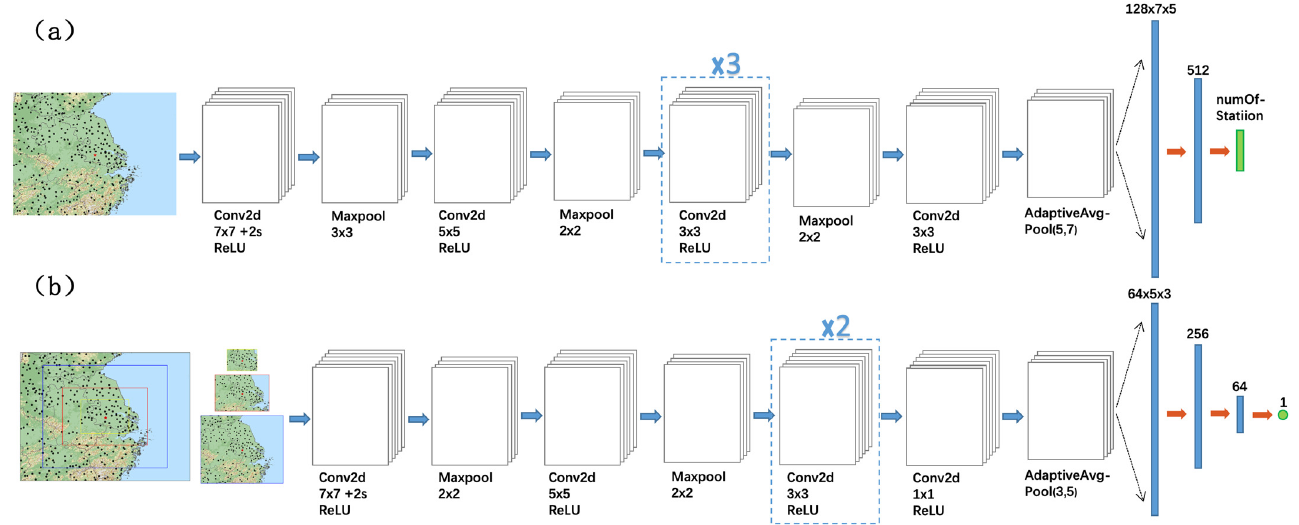
Figure 2. Multisite (G2N, ( a )) and single ‐ site (G2 ‐ One, ( b )) forecast error correction models for grid forecasting. ( a ) Whole grid area as input for multisite correction of 311 sites. ( b ) Different proportions of grid regions as input for single ‐ point correction experiments.